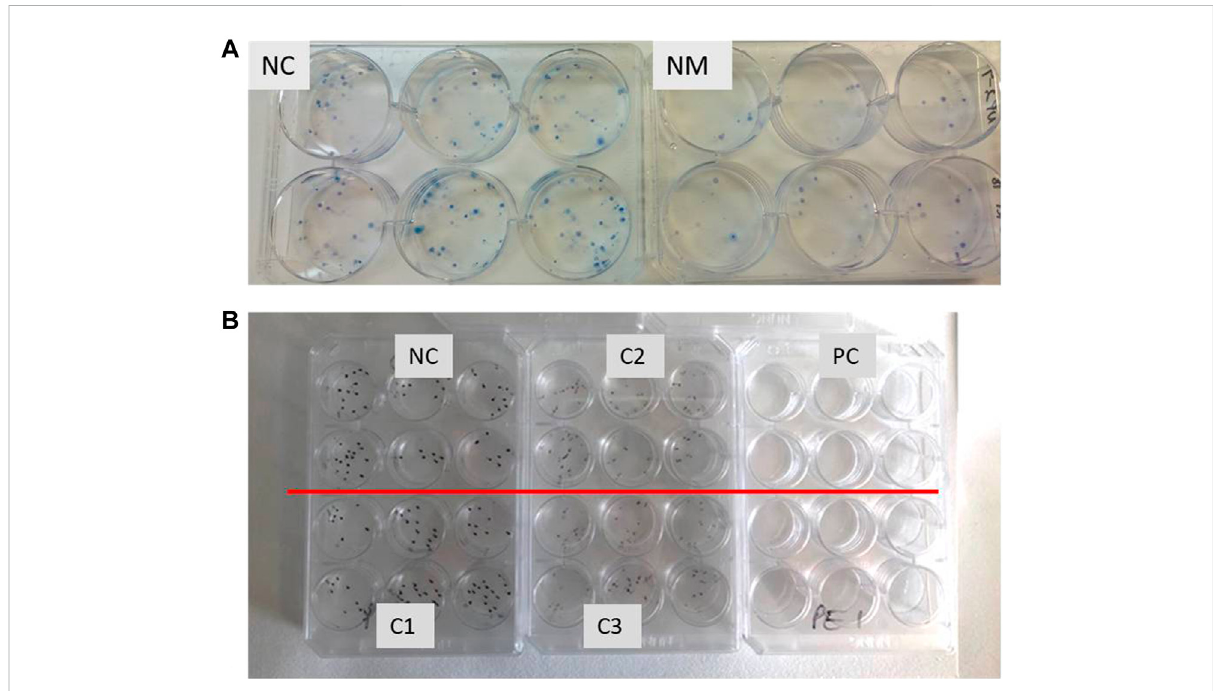
FIGURE 2 (A) Example of six well plates with cell colonies stained with methylene blue. A549 cells exposed to negative control (NC) and nanomaterial (NM), showing cytotoxic effect. Six replicate wells were exposed for each sample. (B) Example of 12 well plates with cell colonies stained